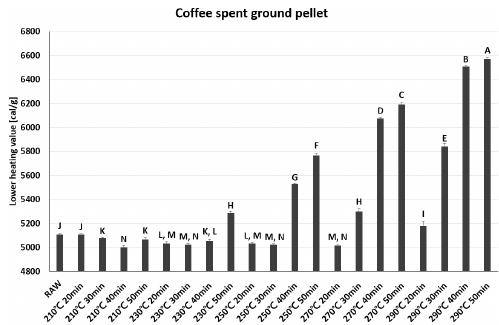
Figure 8. The lower heating value difference of each torrefied pellet.